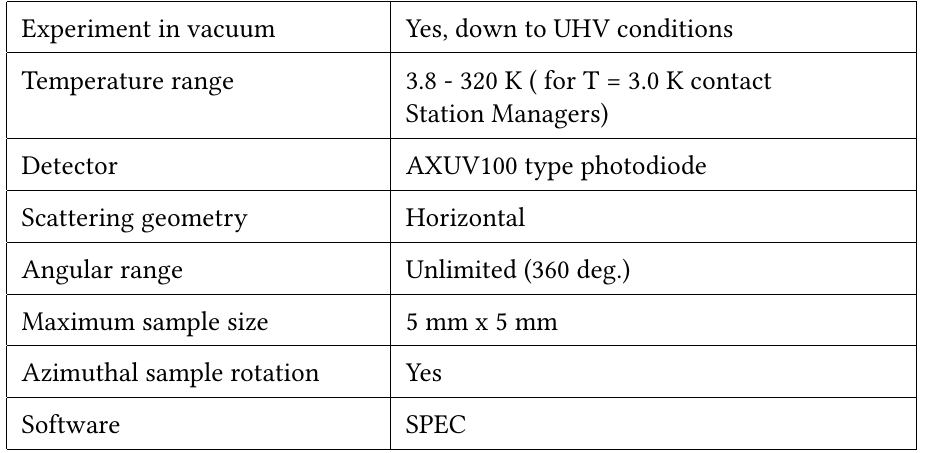
Table 3: Technical data of the XUV Diffractometer at UE46